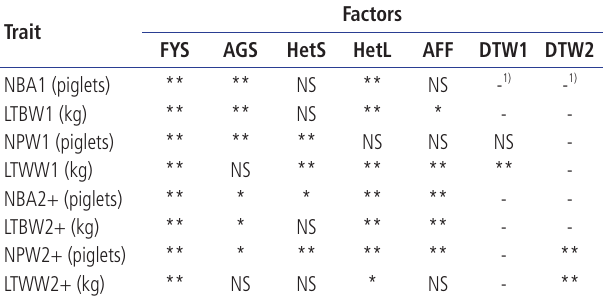
Table 2. Levels of significance for factors included in the single-trait fixed model Trait